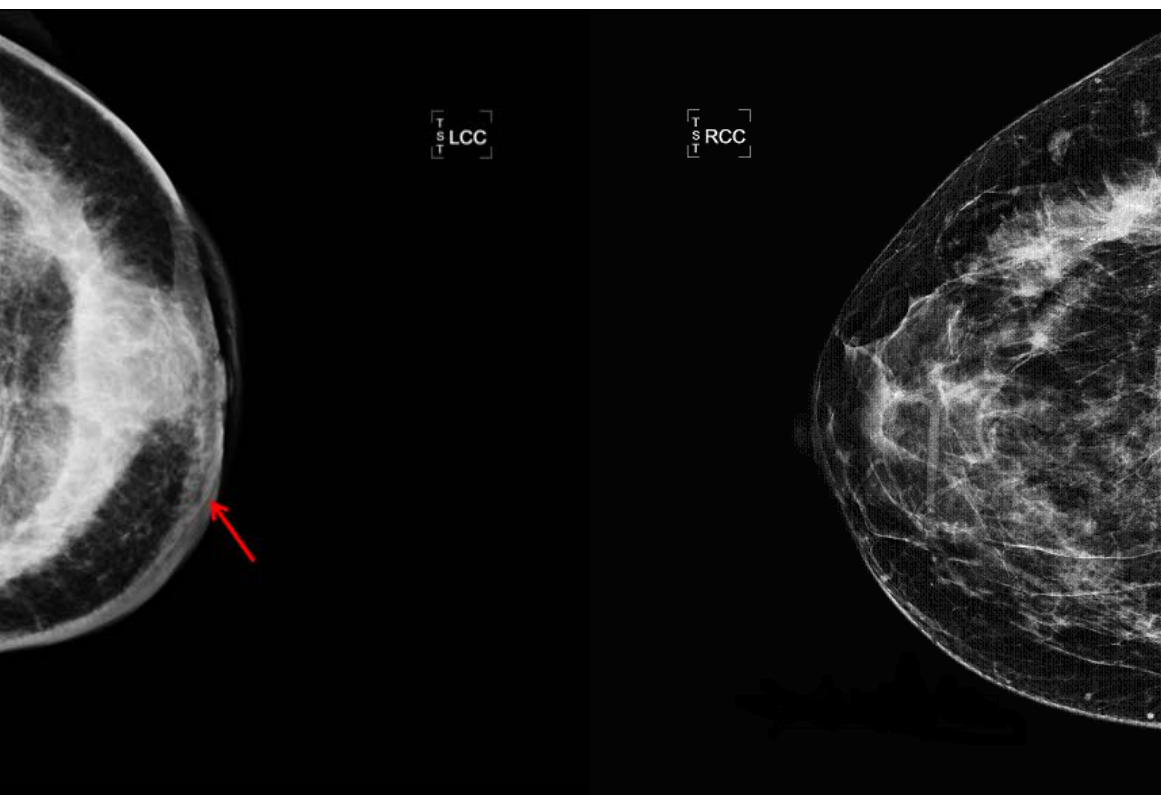
Figure 2. Radiologic photos of IBC patient. The arrow shows thickening of the skin of the left breast due to edema which is characteristic of inflammatory breast cancer. The density in IBC cases may be diffuse or localized. The other mammogram is of the uninvolved right